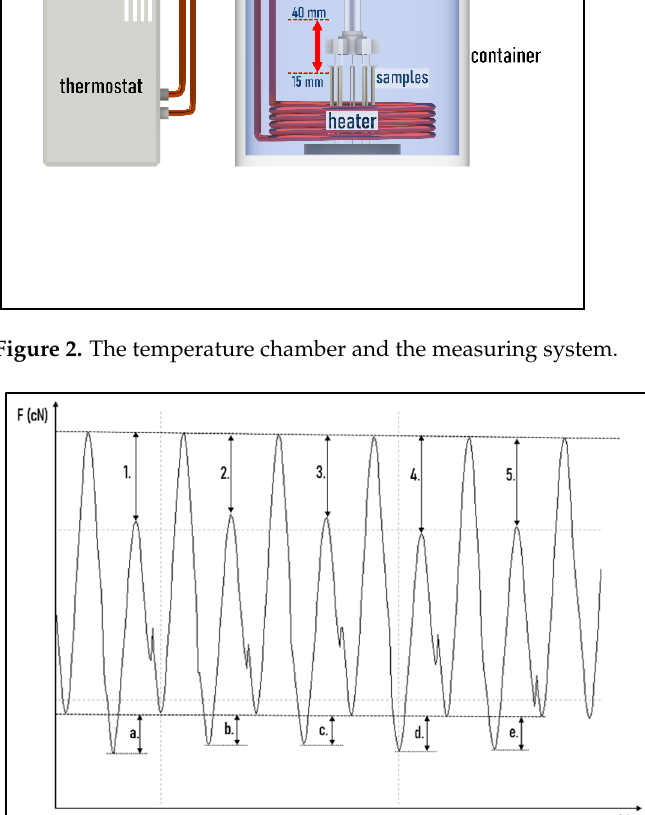
Figure 2. The temperature chamber and the measuring system.